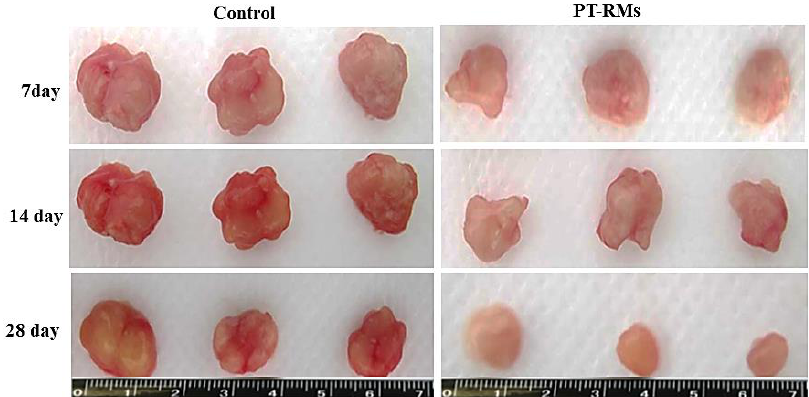
Figure 10. Time-dependent tumor volume reduction study. A volume reduction is found for freshly excised tumor chunks incubated with PTX loaded PT-R-Ms, while control tumors remained the same size ( p < 0.05).